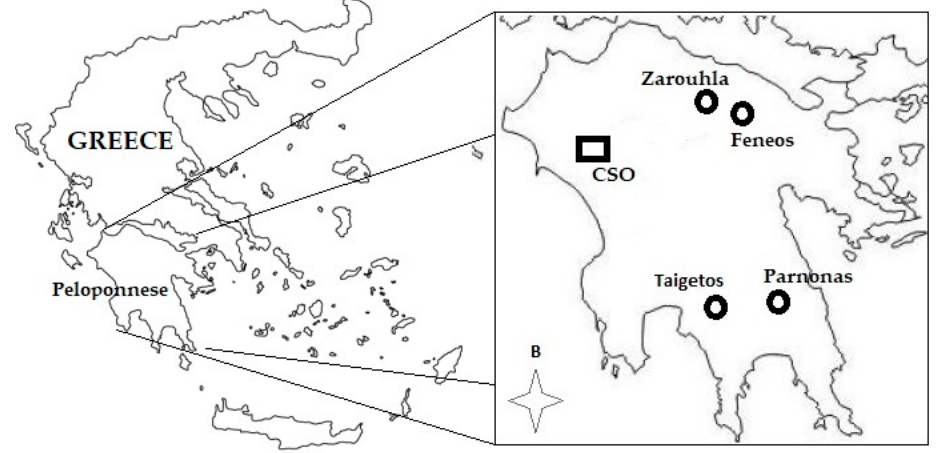
Figure 6. The positions of the provenances (circles) and the clonal seed orchard (CSO).